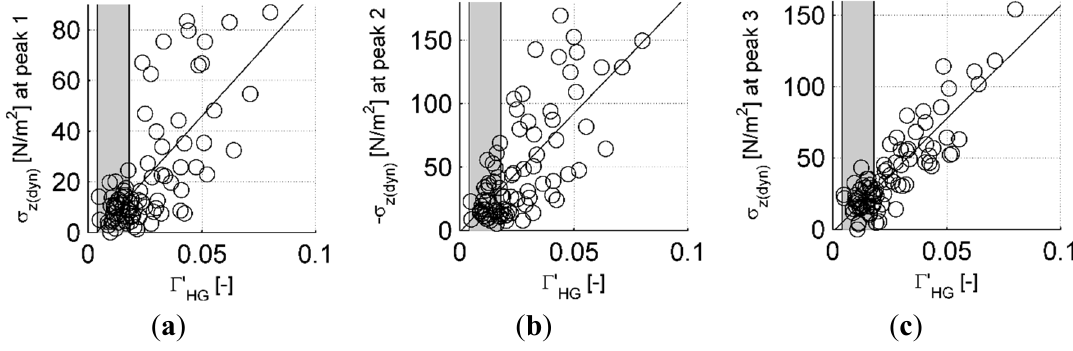
Figure 7. Dynamic lift for Peak 1 ( a ), Peak 2 ( b ), and Peak 3 ( c ), plotted with trend lines over the hydrographs unsteadiness parameter. The grey area covers the range of unsteadiness parameters addressed in [3] ( 0.004 < (cid:1985) < 0.018 (cid:3009)(cid:3008)